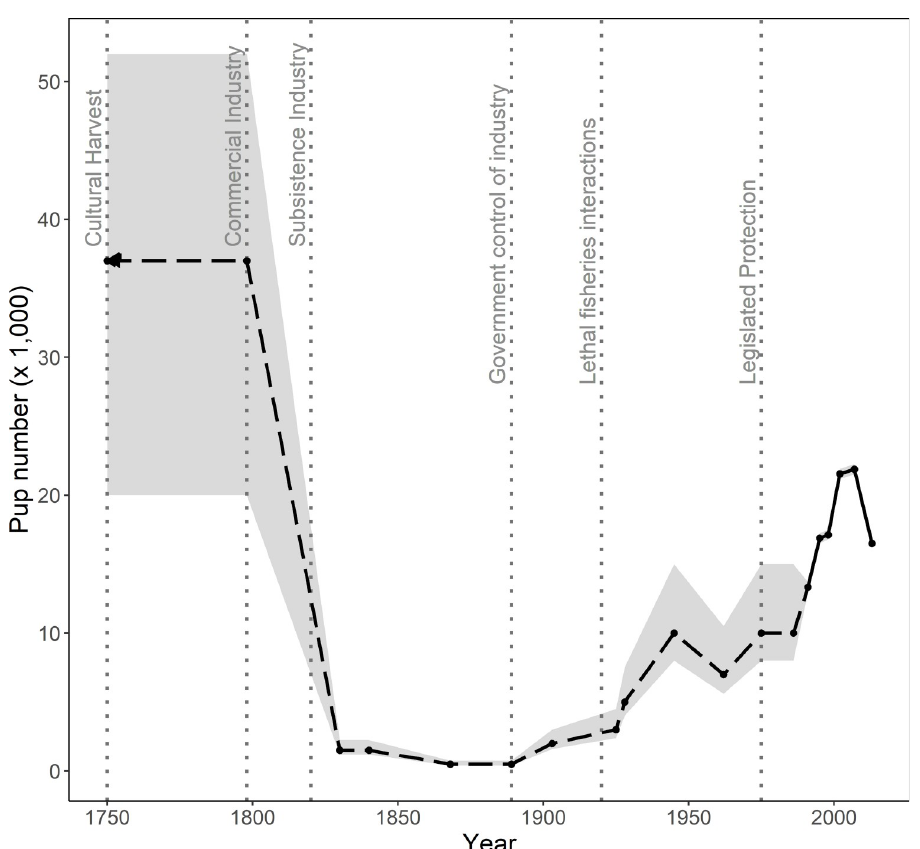
Fig 2. Estimated change in pup numbers of Australian fur seals from 1750 to 2013 (dashed and solid line), assuming thousands of years stability during hunting and cultural use by Aboriginal peoples (Cultural Harvest). The dashed line indicates high levels of uncertainty in the data, the solid line high reliability. Key anthropogenic influences are marked by the dotted vertical lines; the left arrow identifies continuity. Harvesting by commercial sealers began in the late 1700s (Commercial Industry) and declined rapidly to a subsistence industry (Subsistence Industry) when the government protected the seals to some degree and restricted harvesting (Government control of industry). Legal culls and lethal killings by fishers (Lethal fisheries interactions) limited population growth until legislated protection (Legislated Protection) of fur seals in 1975. The shaded ribbon estimates the upper and lower confidence levels for each estimated datapoint, which has improved with standardised and synchronised censuses and represent 95% confidence intervals from 1991–2013. Data and sources provided in (S1 Table in S1 File).